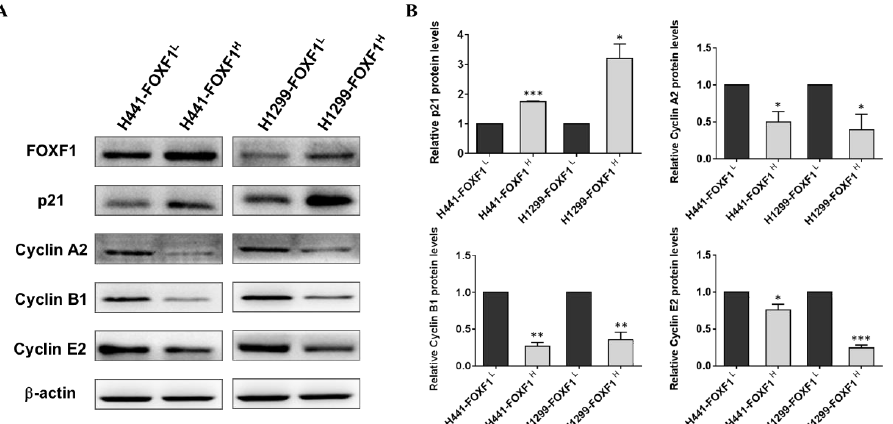
Figure 4. FOXF1-mediated regulation of cell-cycle regulatory proteins. ( A ) Representative Western blots showing expression of FOXF1, p21, and cyclins A2, B1, and E2 in highly FOXF1-expressing non-small-cell lung cancer (NSCLC) cell lines (H441-FOXF1 H and H1299-FOXF1 H ). ( B ) Quantified protein expressions of p21 and cyclins A2, B1, and E2. β-actin served as a loading control. Data are shown as means ± SE. *, p < 0.05; ** p < 0.01; *** p < 0.001, using paired t -test, compared to respective control.